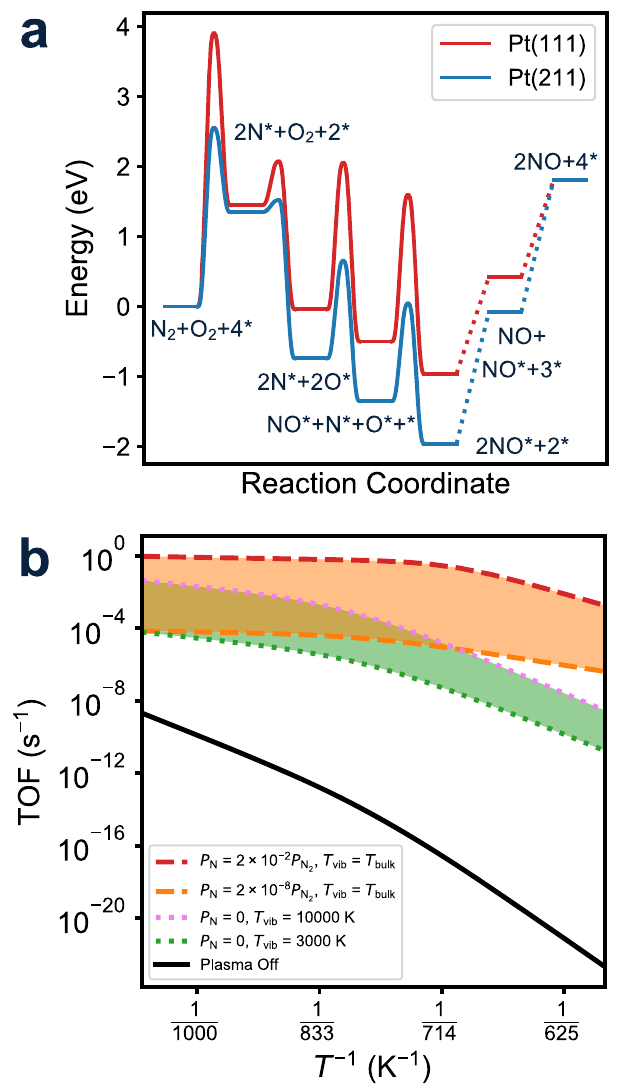
Fig. 3 Microkinetic N 2 oxidation rates. a DFT-reported potential energy surfaces for thermal N 2 oxidation on Pt(211) and Pt(111). b Reaction rates vs. reciprocal temperature on Pt(211) at various vibrational temperatures and N radical partial pressures. Pressures of N 2 and O 2 are 4.995 and 0.005 mbar,